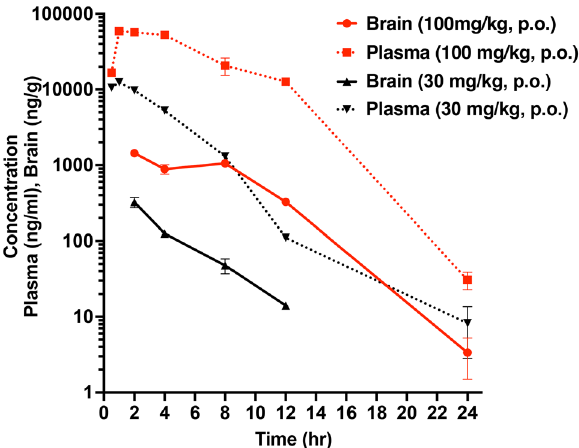
Figure 1. Pharmacokinetic profile of CCR2 antagonist (INCB3344). The CCR2 antagonist was administered to mice (30 or 100 mg/kg, p.o.) for pharmacokinetic studies. The concentrations in the plasma (ng/ml) and brain (ng/g) were measured at time points. Data are shown as mean ± SEM, n = 3 mice per time point.